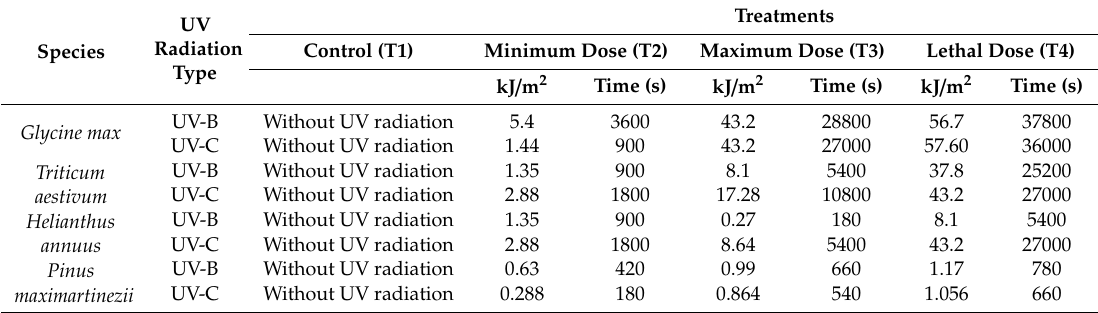
Table 1. Doses of UV-B and UV-C radiations with exposure times for seed germination of four species in a constant irradiance